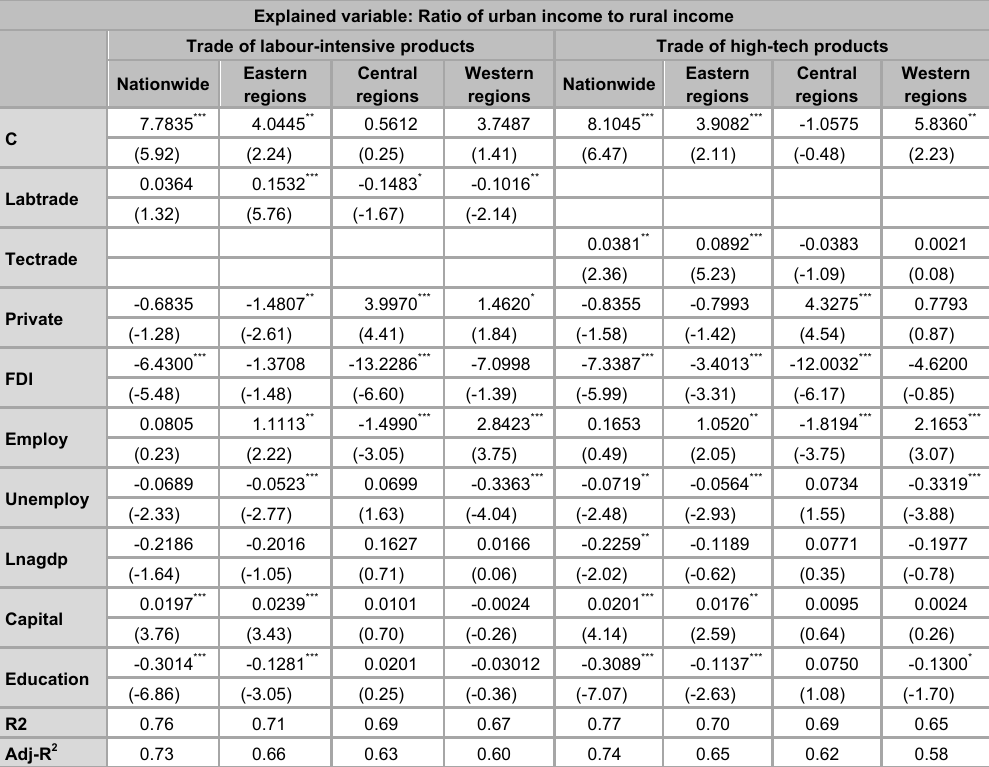
Regression results (1) of trade structure and the urban-rural income gap at both national and regional level: 2000 to